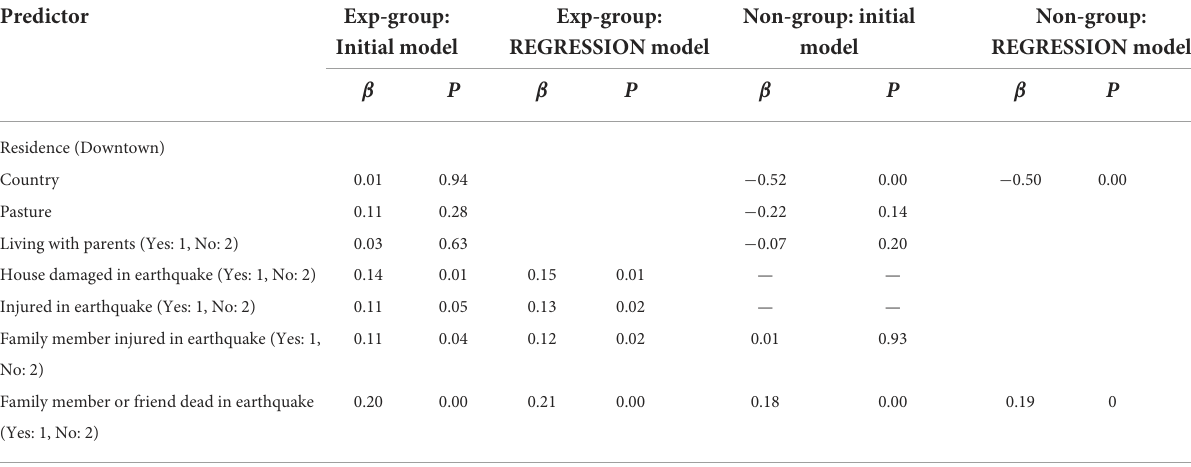
TABLE 2 Results of the multiple stepwise regression analysis for variables predicting PCS scores across the exp-group and non-group. Predictor